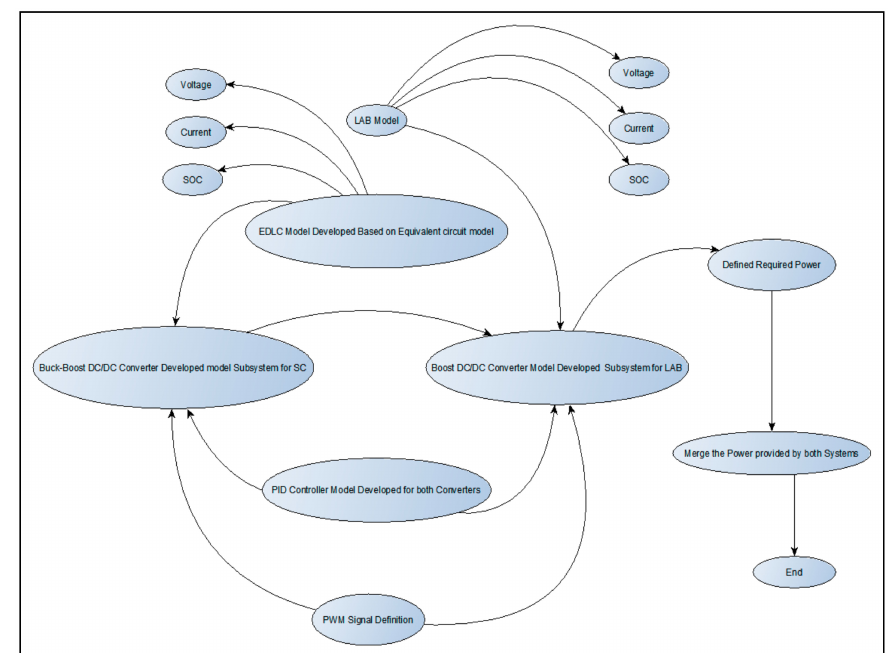
Figure 8. Describes the simulation procedure of the developed model. EDLC—electro double layer capacitor.